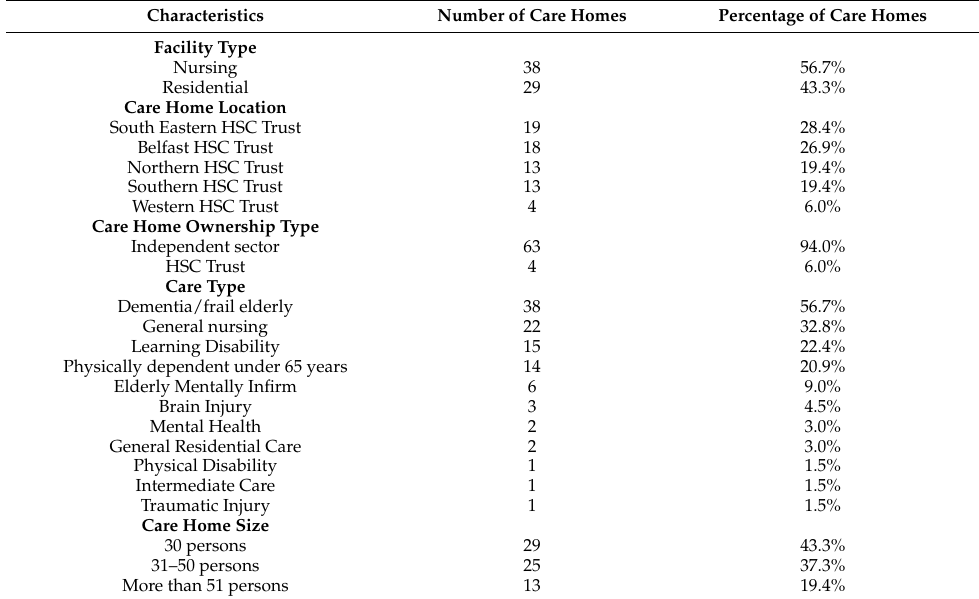
Table 2. Study characteristics of participating care homes ( n =